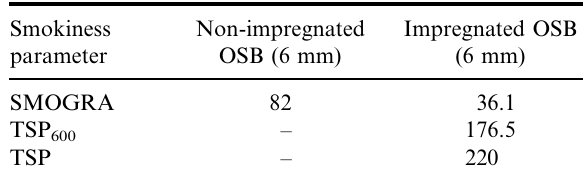
Table 4. Smoke release values of impregnated and non- impregnated (before terminating the test) OSBs.